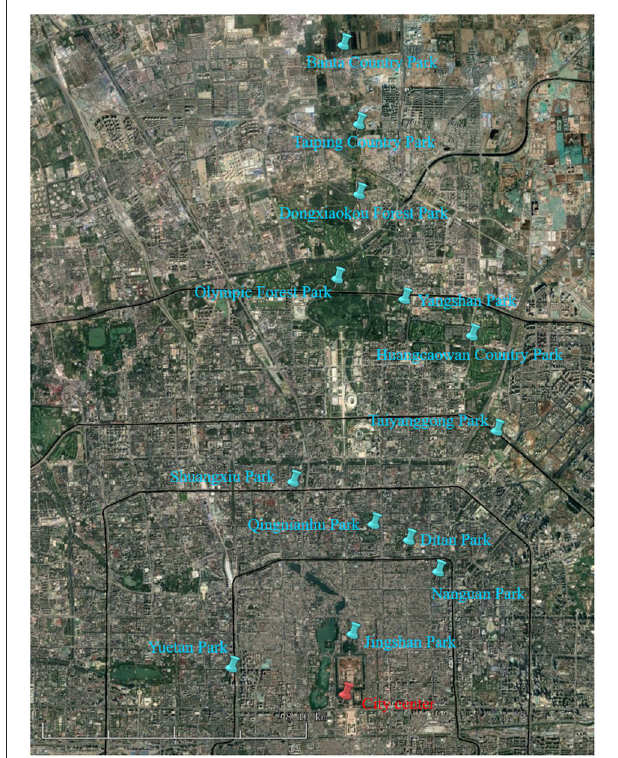
FIGURE 1 | Location of the 13 public parks selected (Background image from Google